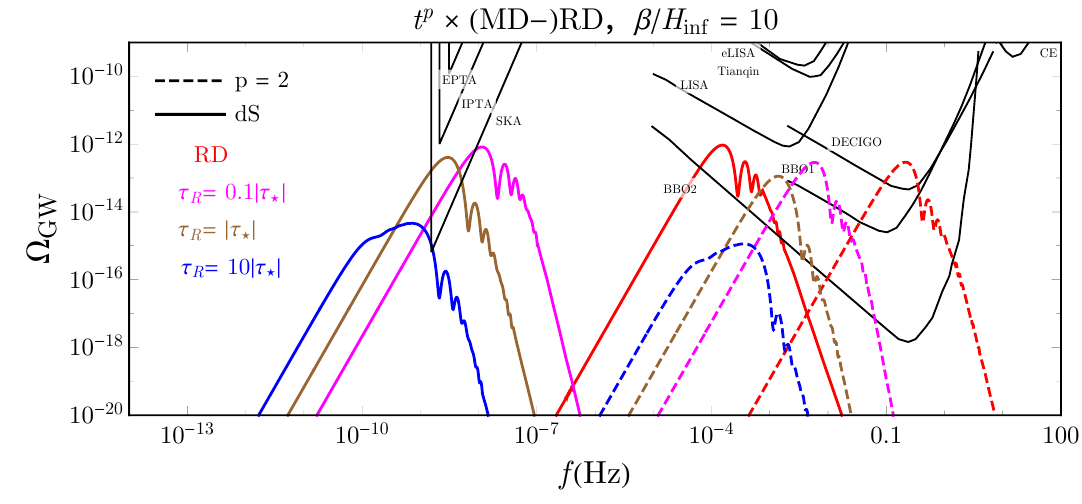
Figure 11 . The GW spectra from the phase transition for t p inflation and (MD-)RD post- inflationary evolution with H inf ’ H ? = 10 8 GeV. The solid line is plotted using p → ∞ (dS inflation) and a ? /a end = exp( − 19) while the dashed line is for p = 2 and a ? /a end = exp( − 23) . Four different colors correspond to different τ R settings. We set β/H ? to be 10. The overall strength of the GW signal scales linearly with ∆ ρ vac /ρ inf ? . For this plot, we have taken the conservative choice of ∆ ρ vac /ρ inf ? = 0 . 1 . The curve for the sensitivity of BBO phase 2 (BBO2) is from [104]. Curves for sensitivities of other detectors are from